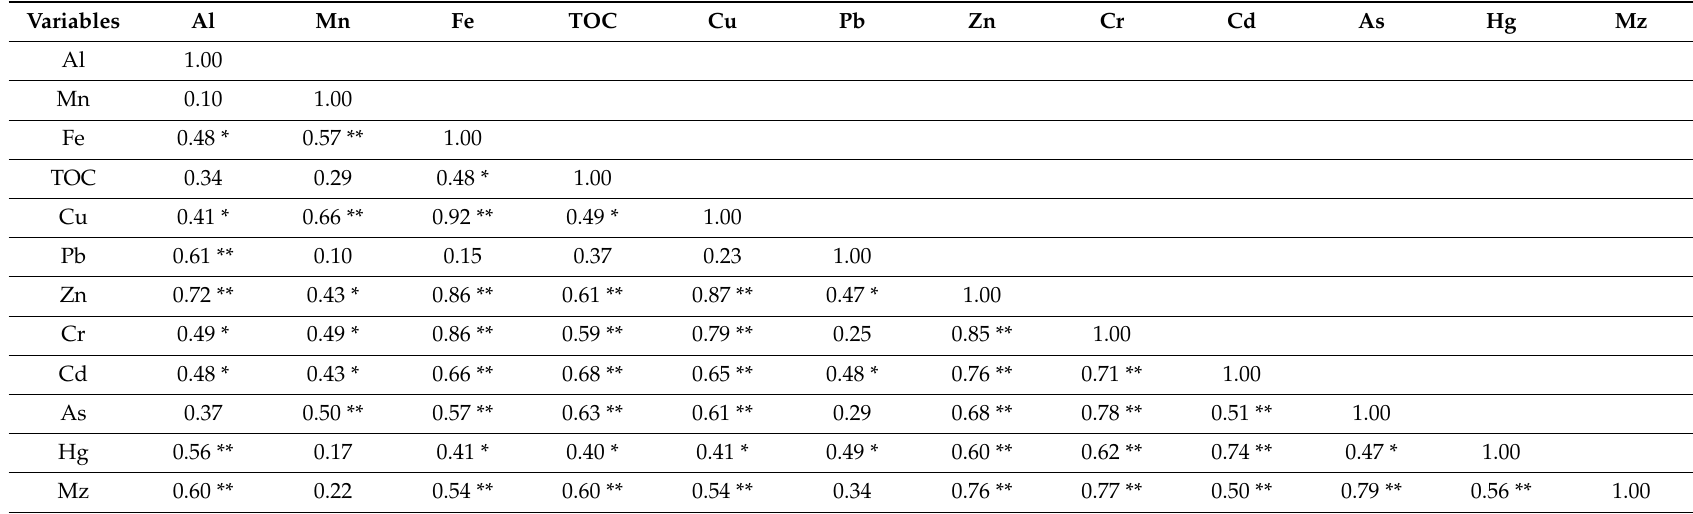
Table 4. Pearson’s correlation matrix for the heavy metals and metalloids and selected elements (Al, Fe, Mn), total organic carbon (TOC) and mean grain size (Mz) (n = 26) in the